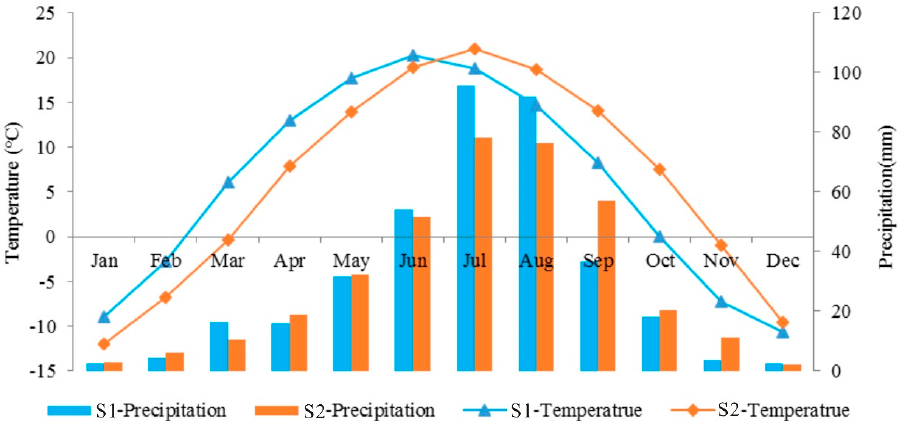
Figure 8. Monthly temperature and precipitation change under different climate scenarios: Scenario 1 ( S 1) and Scenario 2 ( S 2).